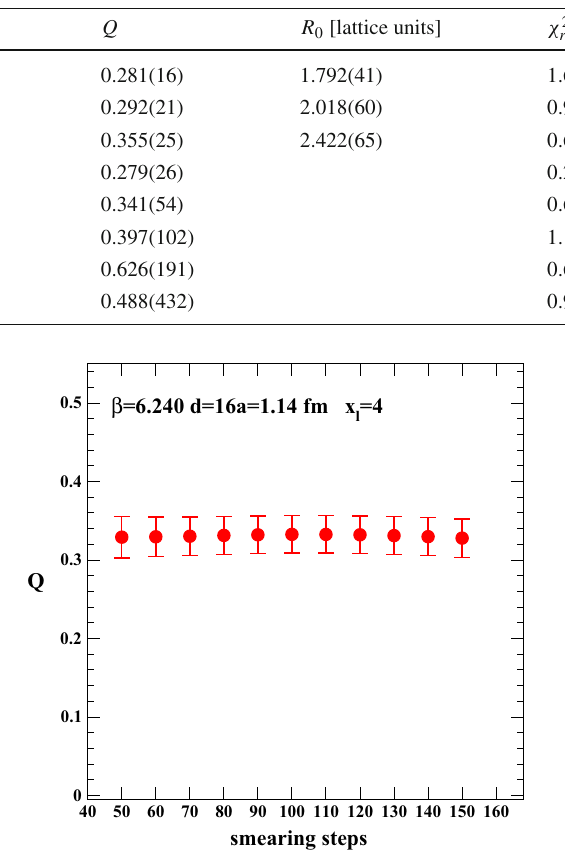
Fig. 13 Q from the Coulomb fit to E y field at β = 6 . 240, d = 16 a (cid:9) 1 . 14 fm, and x l = 4 a versus smearing steps